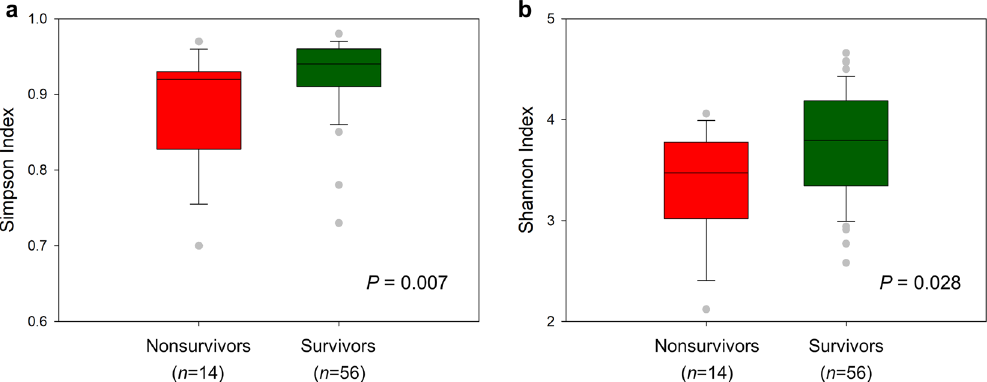
Fig. 3 Comparison of different metrics of α -diversity between nonsurvivors and survivors after matching. a Simpson index, b Shannon index. P values were obtained using the Mann – Whitney U